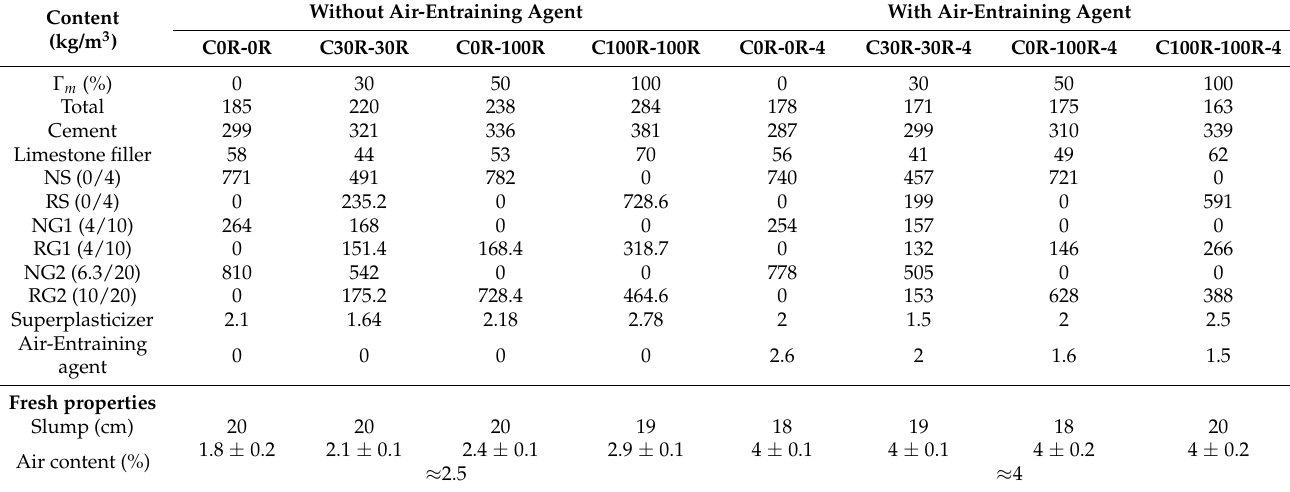
Table 1. Mix proportions of concrete